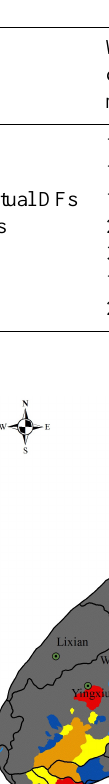
Table 5. Comparison of the prediction results of the two systems.